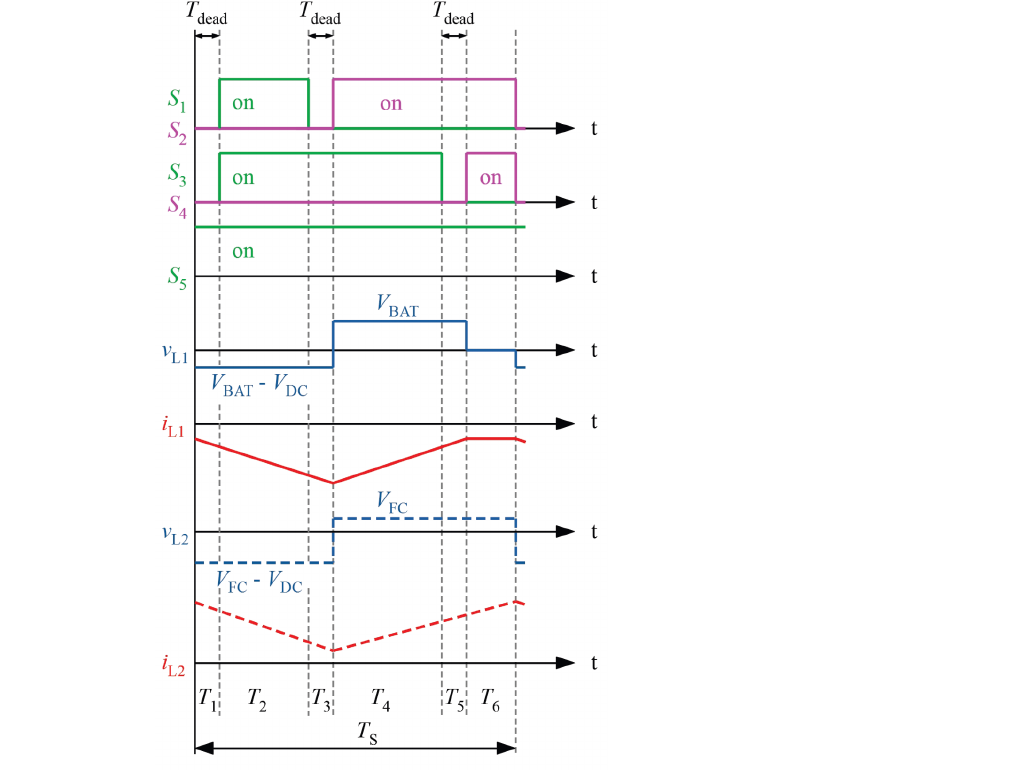
Figure 18. Active switch states, inductor voltages and inductor currents for FC2BDC- Boost mode.